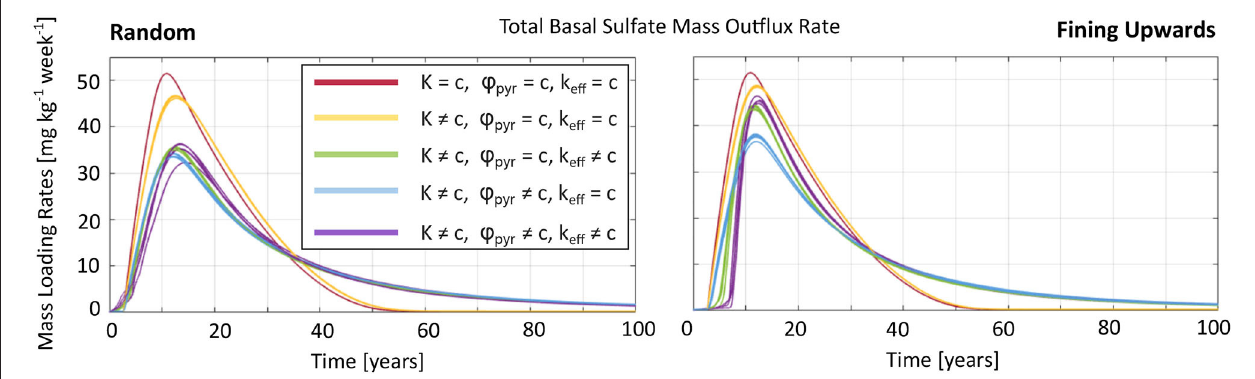
FIGURE 6 | Comparison of the effects of heterogeneity on basal sulfate mass loading rates, influenced by physical and chemical heterogeneities. Plots on the left show results from models with “random” material property distributions; models that include “fining upwards” trends are shown on the right. From the legend: K is hydraulic conductivity, ϕ pyr is the pyrite volume fraction (controlling differences in NP:AP ratios), and k eff is the effective rate of pyrite oxidation, and “c” refers to constant (or homogeneous spatial distribution for that parameter). Curves with the same colors represent the various realizations of a case with different randomly generated spatial distribution of parameters. Specifically, Red: reference/homogeneous case. Yellow: K is spatially varied, ϕ pyr and k eff remain constant. Green: K and k eff spatially varied, ϕ pyr is constant. Blue: K and ϕ pyr are spatially varied, k eff is constant. Purple: K, ϕ pyr , and k eff are spatially varied. In all cases where K is not constant, porosity is also spatially